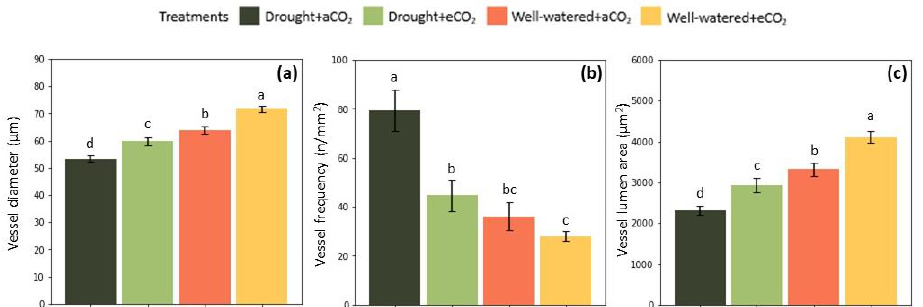
Figure 7. Effect of elevated CO 2 (950 ppm) and cyclic drought stress in the mean value (± confidential level of 95%) of Eucalyptus grandis vessel ( a ) diameter, ( b ) frequency, and ( c ) lumen area, at the end of the growth season. Different small letters indicate statistical significance between the means ( p < 0.05).